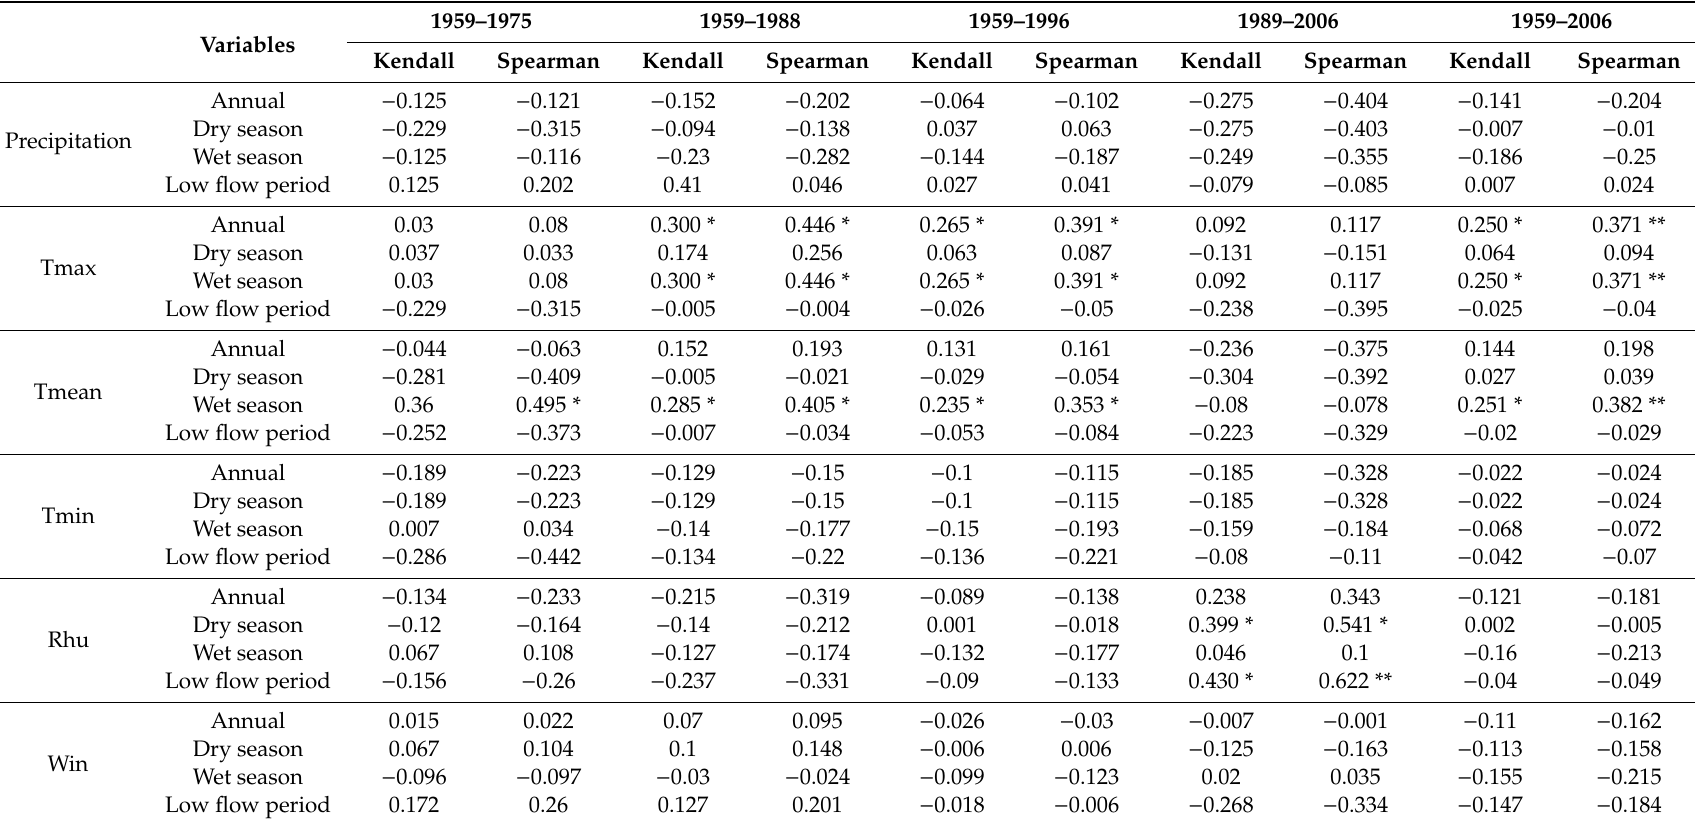
Table A2. Correlation analysis between low flow magnitude and climate